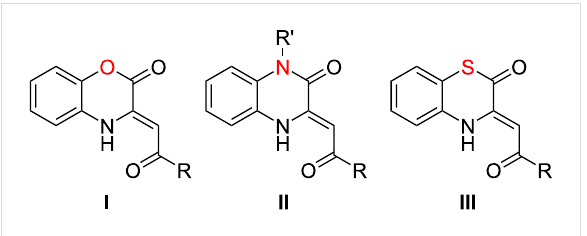
Figure 1: Enaminones fused to heterocyclic